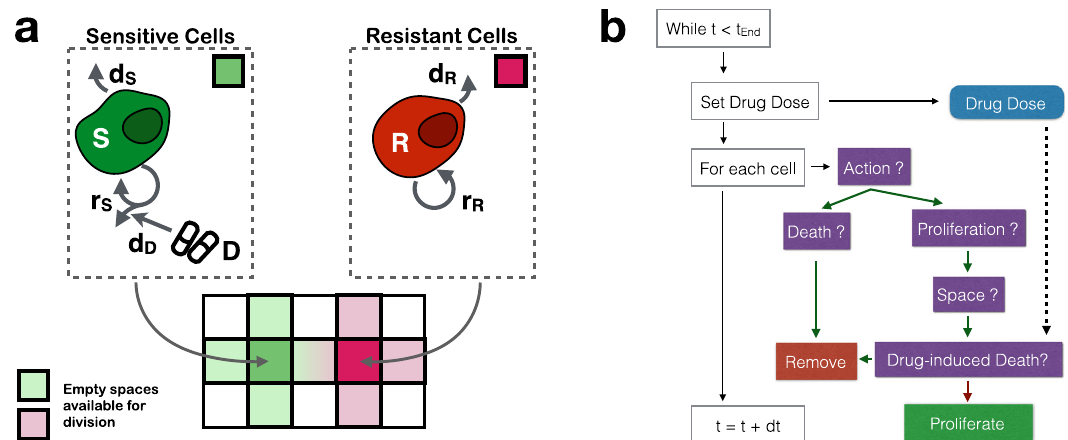
Fig. 1 The agent-based tumour model. a The tumour is modelled as a mixture of drug-sensitive ( S ) and resistant cells ( R ), where each cell occupies a square on a 2-D equi-spaced lattice. Cells divide and die at constant rates r S and r R , and d S and d R , respectively. Daughter cells are placed into empty squares in a cell ’ s von Neumann neighbourhood. Drug ( D ) will kill dividing sensitive cells at a probability d D . b Flow diagram of the simulation algorithm ( t End : end time of the simulation; dt: simulation time step). For parameter values, see Table